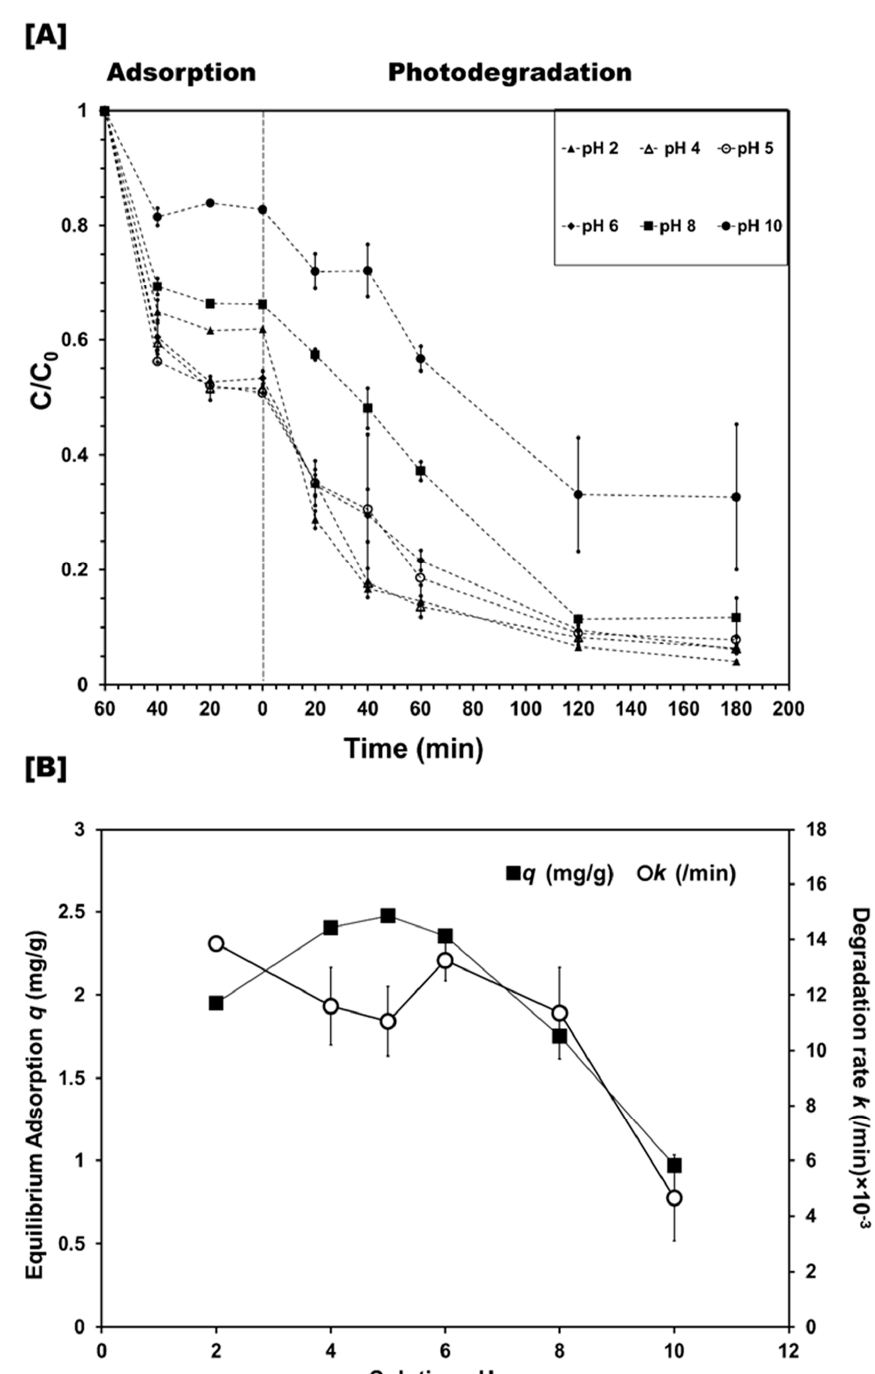
Figure 6. ( A ) Photodegradation of CBZ at different solution pH and ( B ) effect of solution pH on equilibrium adsorption q and degradation rate k (experimental conditions: initial CBZ concentration = 5 mg/L; concentration of UiO-66_GO-0.5 = 1 g/L; solution volume V = 50 mL). Plots and error bars represent averages and standard deviations from duplicate experiments.